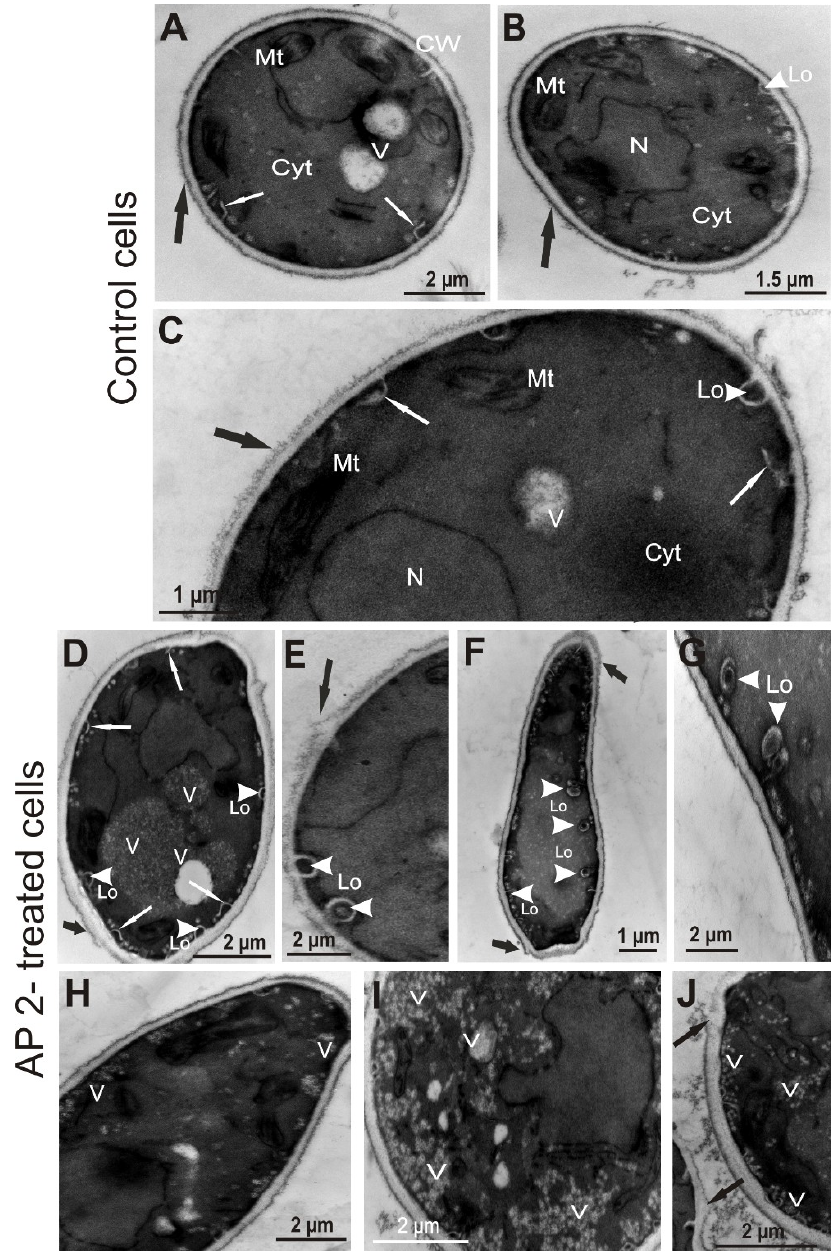
Figure 5. TEM images of C. albicans cells treated with AP2 for 3 h. The log-phase cells were incubated without (control; A – C ) or with 5 μM AP2 ( D – J ) at 37 °C for 3 h. Then, the cells were imaged by TEM. A , B —control cells with well discernible cytoplasm (Cyt), nucleus (N), mitochondria (Mt), vacuoles (V), cell wall (CW) and short, evenly distributed fibrils (black arrows) attached to the cell wall. In (A) invaginations of the cell membrane are indicated by white arrows. In (B) a lomasome (Lo) is marked with white arrowhead. C —a portion of the control cell showing clearly the presence of cell wall fibrils (black arrow), a lomasome (Lo, white arrowhead), and cell membrane invaginations (white arrows). D , E —AP2-treated cells with some distortion of the cell wall (black arrows), many membrane invaginations (white arrows) and lomasomes (Lo, white arrowheads), and big vacuoles (V). F , G —a cell and its enlarged view with well discernible lomasomes in the form of vesicular bodies (Lo, white arrowheads) inside the cell. H – J —fragments of cells with vacuolated cytoplasm (V) and some distortion of the cell wall (black arrows).